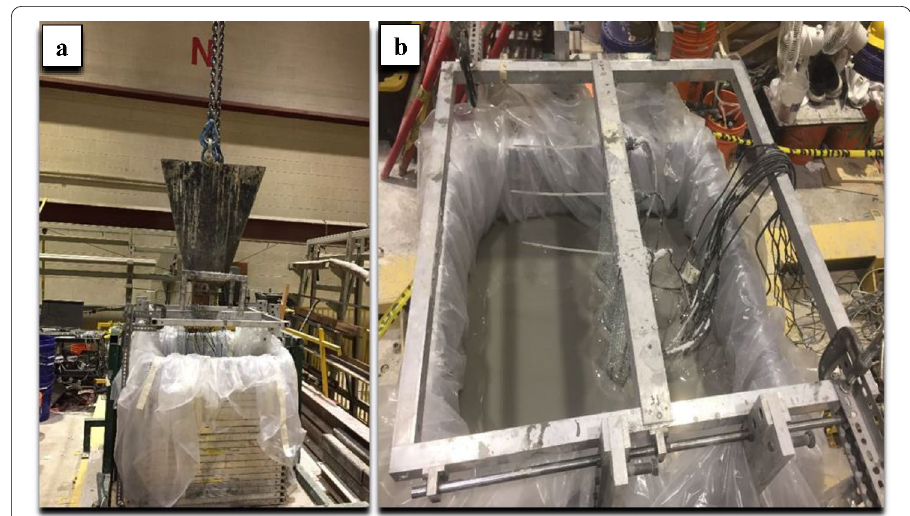
Fig. 5 a Snapshot showing the concrete bucket that was used for deposition of thickened tailings layers. b Snapshot of the ground surface of thickened tailings shortly after deposition of the third (top)